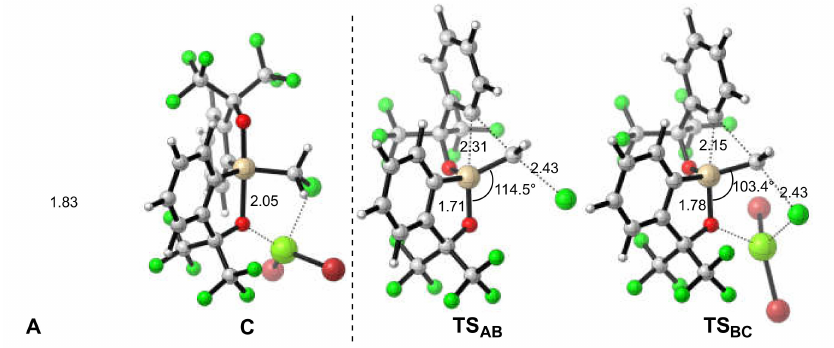
Figure 4. Representation of some relevant calculated